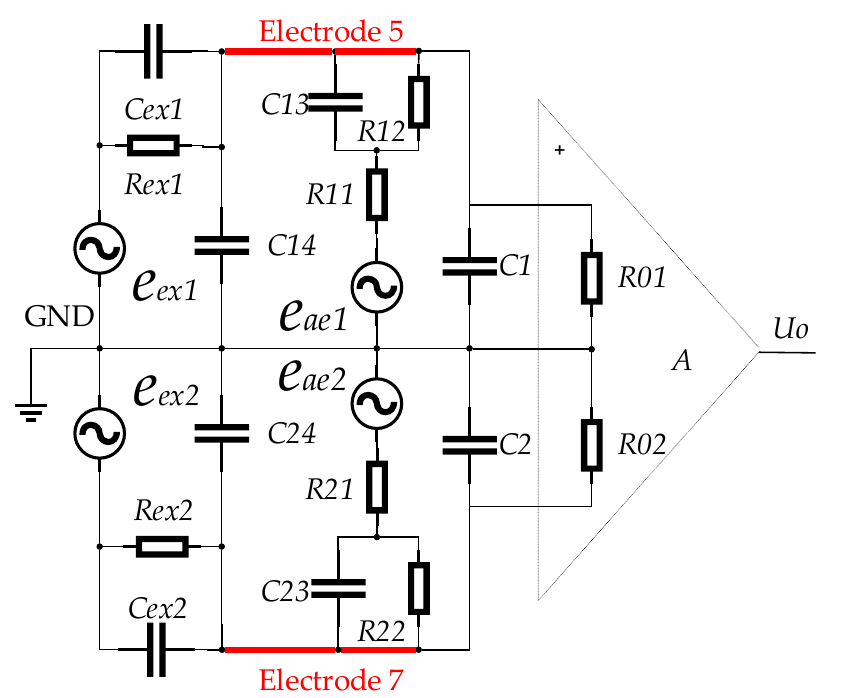
Figure 9. Equivalent circuit of electrode measurement circuit based on electric